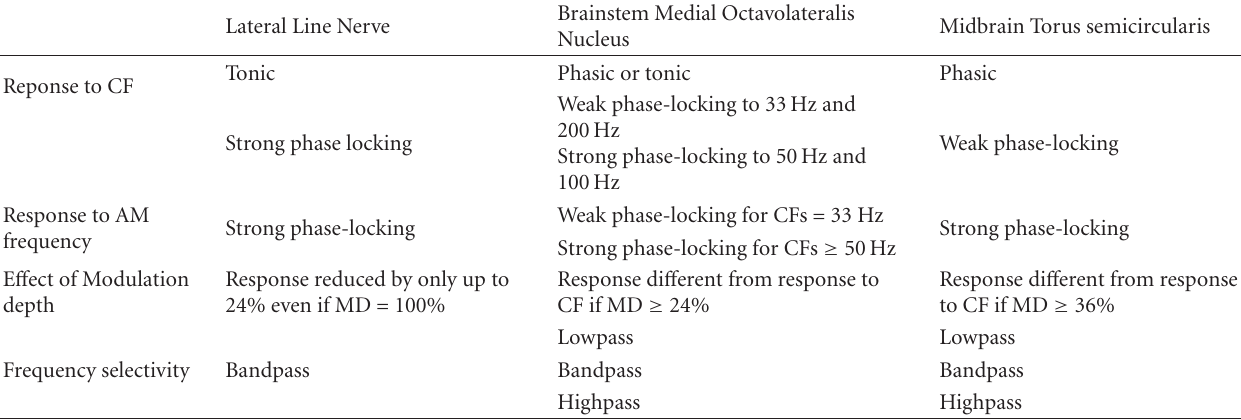
Table 1: Comparison of the properties of the responses of lateral line nerve fibres [15], brainstem units (present study) and midbrain units [10] to constant-amplitude and amplitude-modulated sine wave